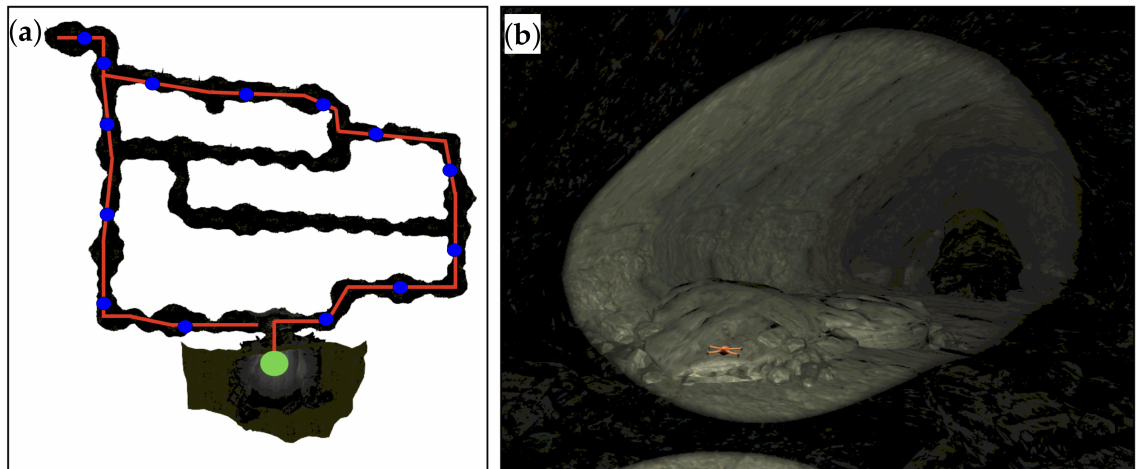
Figure 15. DARPA SubT simulation world: Simple Cave 02, 230 m × 170 m × 75 m ( a ) Top-down view of cave environment consisting of large unstructured tunnels. The red line in Figure 15 shows the approximate route taken by the system through the cave environment starting at the green dot near the bottom and proceeding counter-clockwise. ( b ) View of the orange quadrotor system moving through a larger cavern.